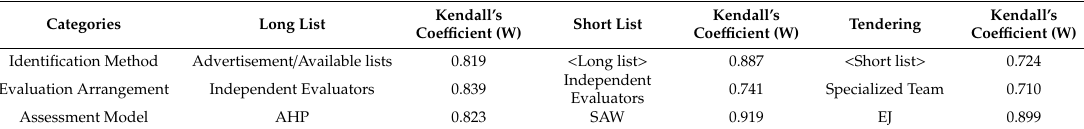
Table 11. Proposed procedures of evaluation of Construction